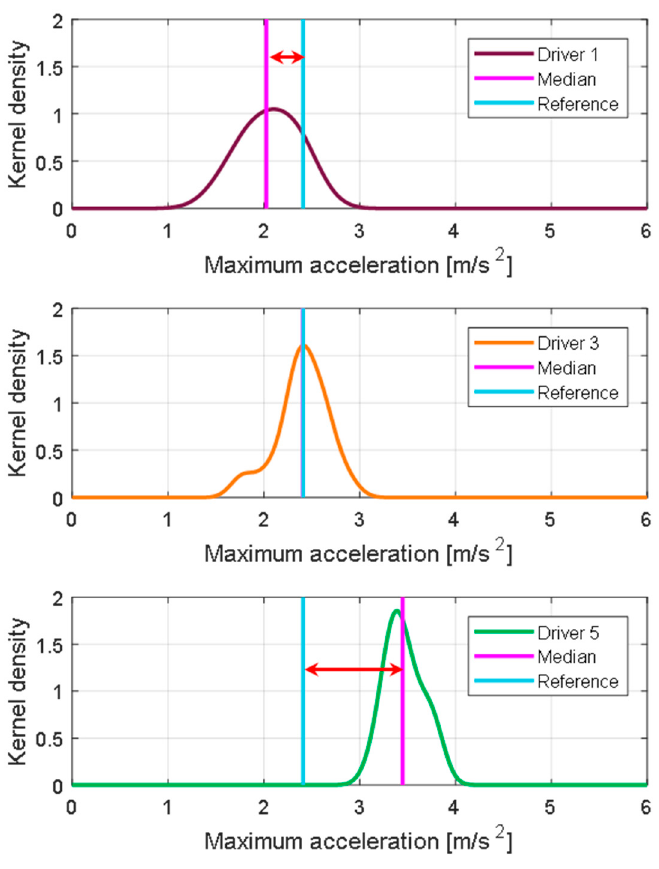
10 of 20 Table 2. Median values of the driving features. Driver #